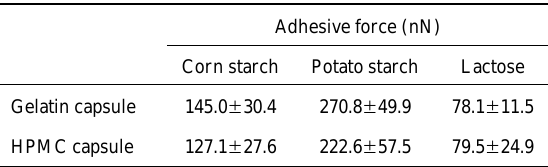
Table 3 Adhesive Force between Particles on the Gelatin Capsule and HPMC